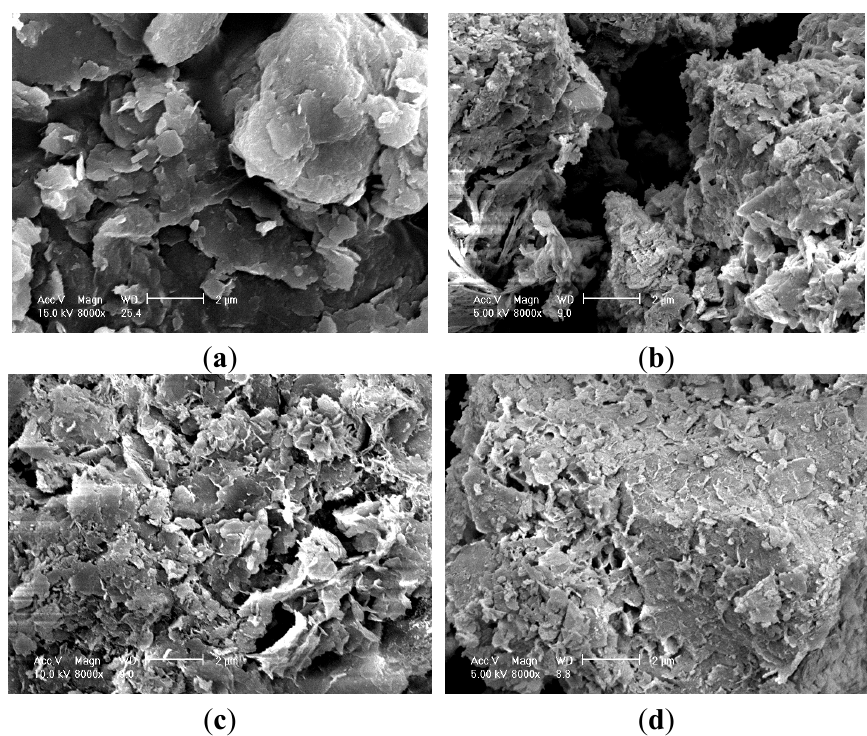
Figure 9. Scanning electron microscopy (SEM) photograph of organic clayey soil and mixtures with different types of admixtures. ( a ) Sediment; ( b ) OPC; ( c ) OPC + OSP; ( d ) OPC +